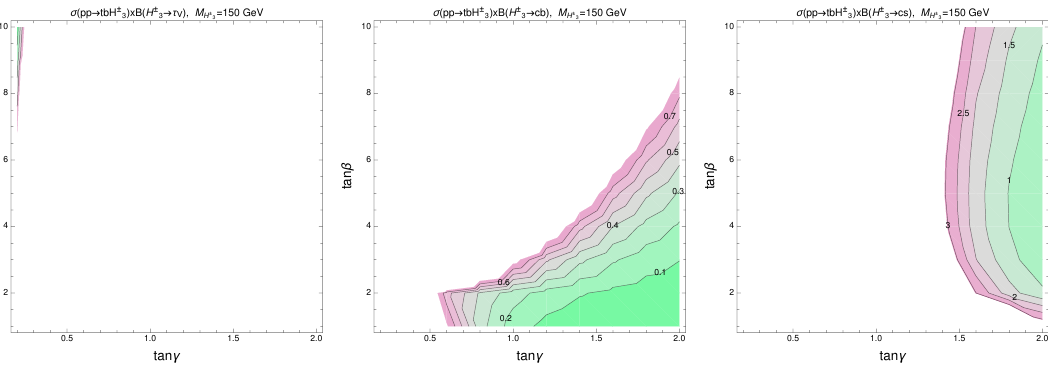
Figure 4 . Production cross sections times BR for a 150 GeV heavier charged Higgs H ± decaying 3 to τν (left), cb (middle) and cs (right) in the ( tan γ, tan β ) plane, for M = 80 GeV, θ = − 0 . 5 , and H ± 2 δ = 0 . 95 π . The white area represents the upper limits from LHC searches in refs. [25] (CMS), [26] (CMS), and [27] (ATLAS), respectively. Notice that the H ± → τν limits strongly exclude almost 3 all of this scenario. The H ± signal on the other hand is well below the collider 2